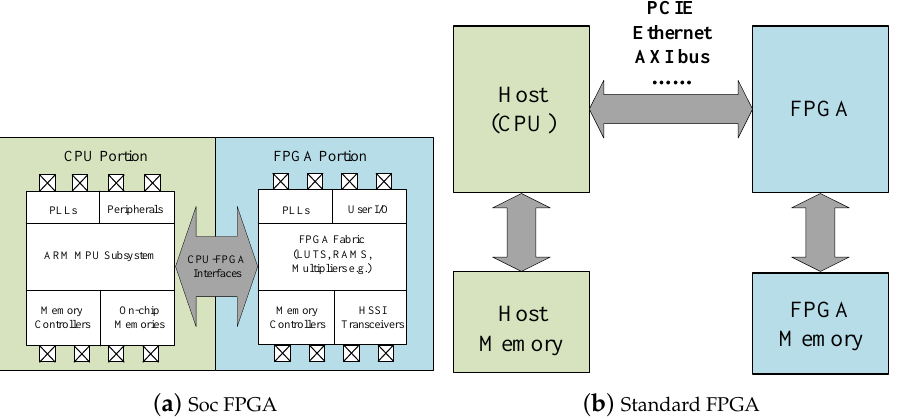
Figure 3. Two FPGA architectures. ( a ) is Soc FPGA which combines both FPGA and GPU in the same package. ( b ) is standard FPGA. The logic module and computing module are separated. In edge scenarios, both sorts are usually designed in only one board with other functional modules, but they do have differences in resources and bandwidth due to their diverse connection pattern and